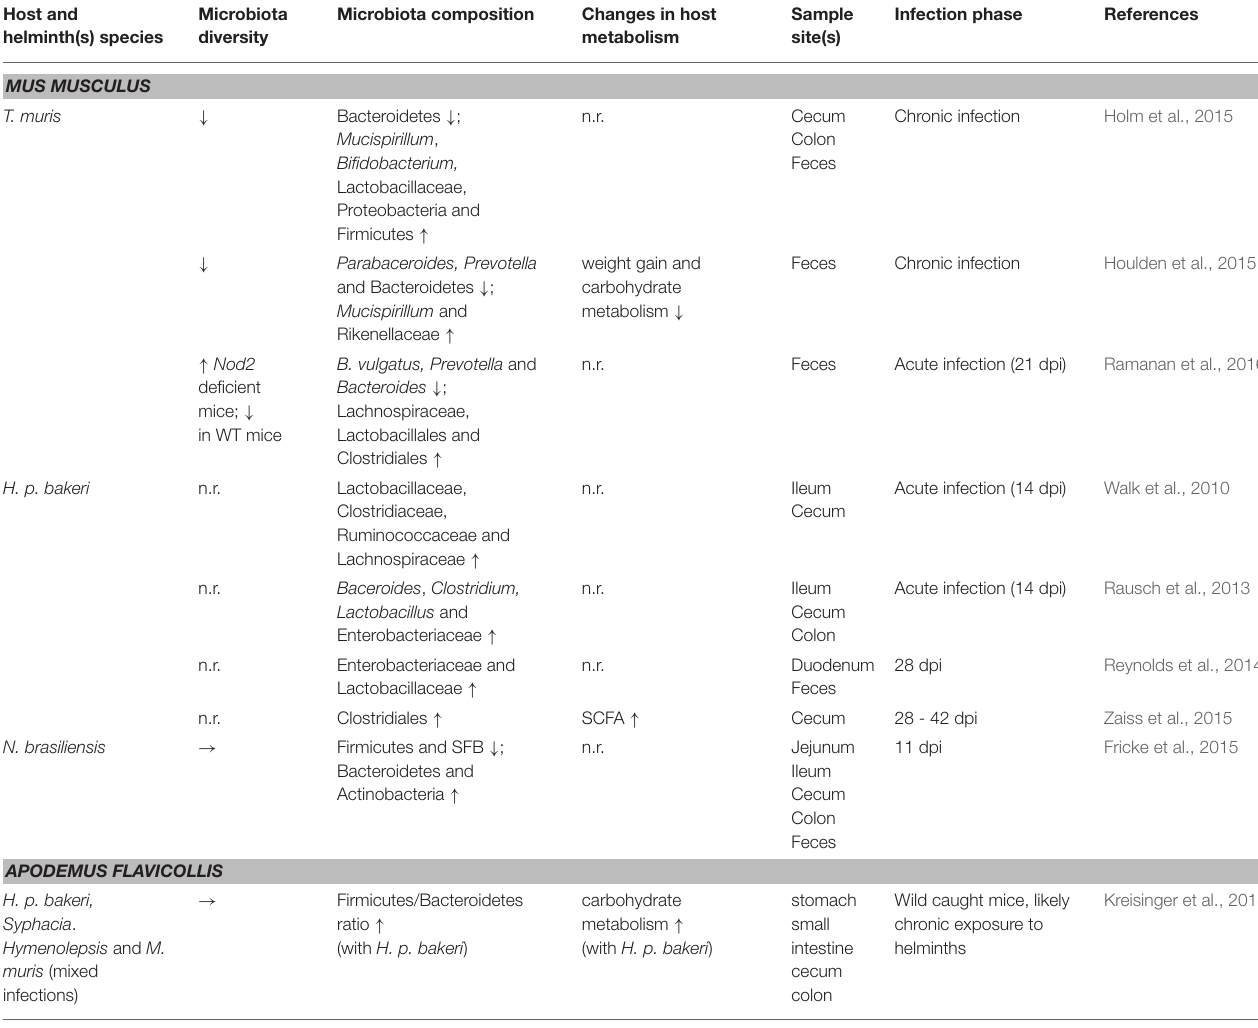
TABLE 2 | Effects of helminth infection on host microbiota and metabolism in